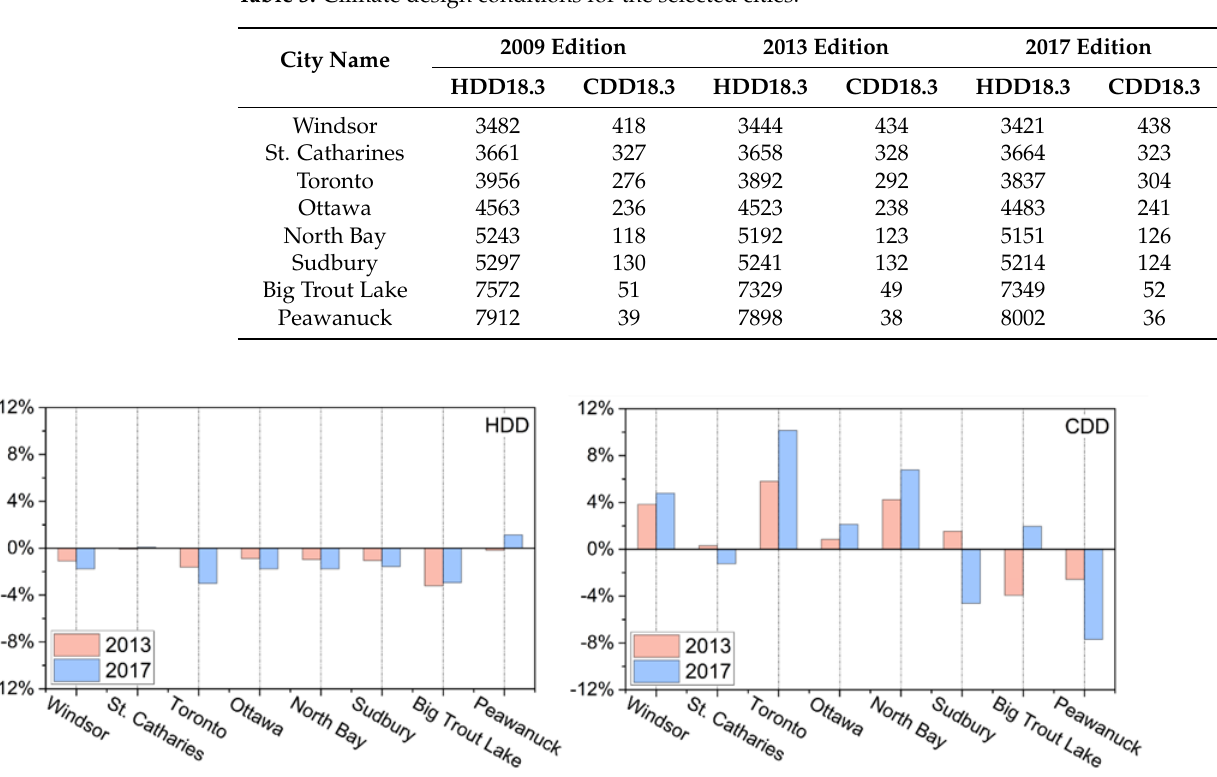
Table 3. Climate design conditions for the selected cities.